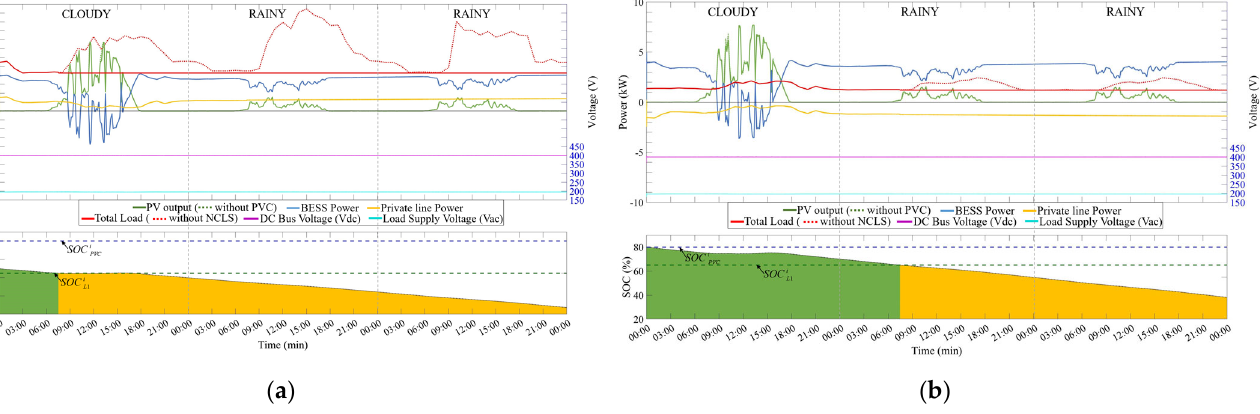
Figure 13. Test case 4 (Connected). ( a ) Performance of prosumer X. ( b ) Performance of prosumer Y.